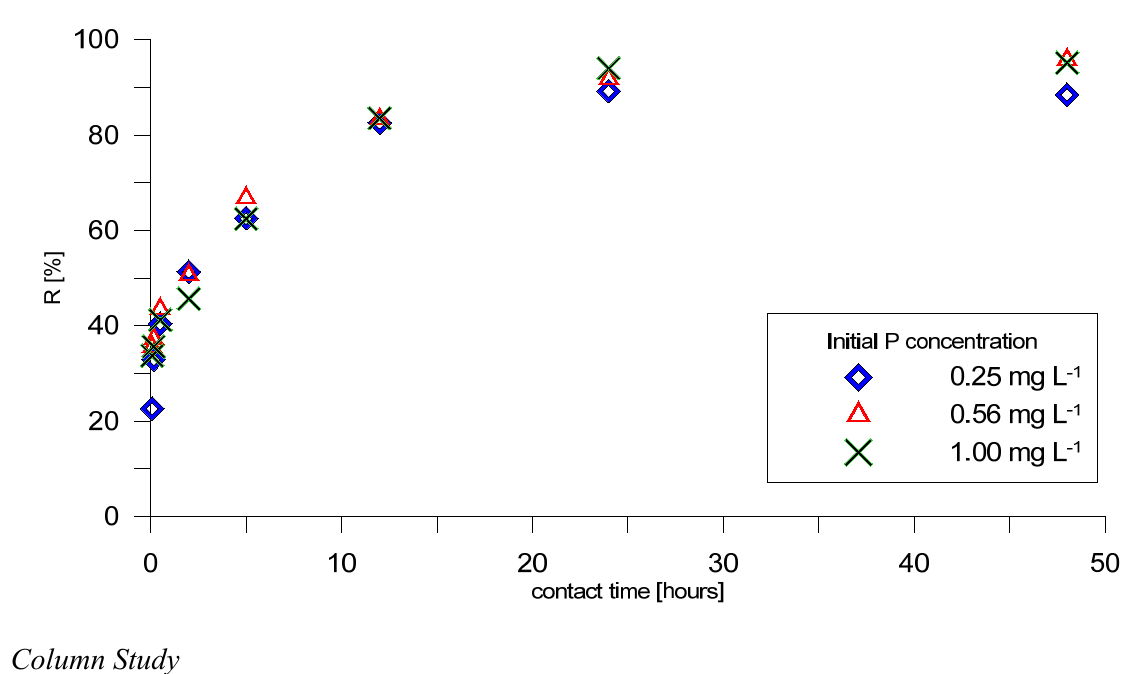
Figure 4. P sorption kinetic for different initial P